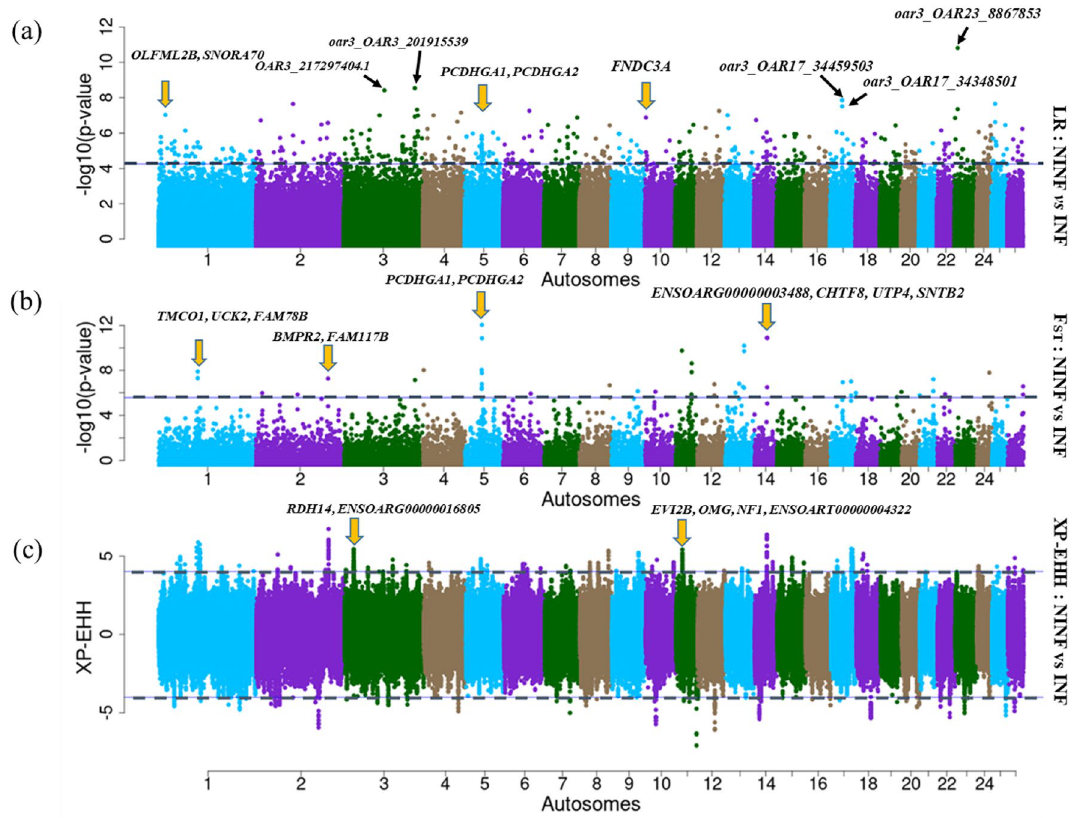
Figure 4. Manhattan plots showing the genome-wide distribution of SNPs following ( a ) LR-GWAS ( b ) F ST and ( c ) XP-EHH analysis using the non-infected and infected cohorts of autochthonous Tunisian sheep. INF infected cohort; NINF non-infected cohort.